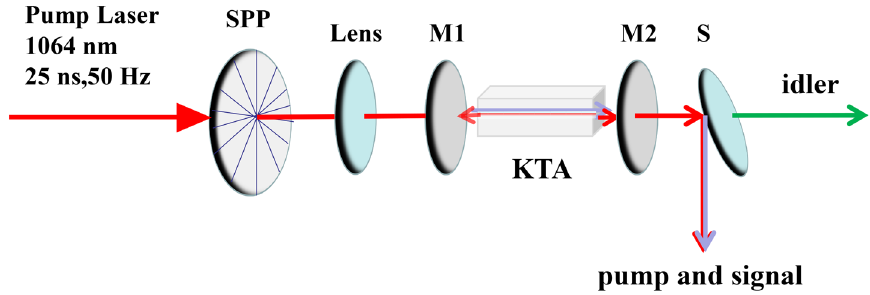
Figure 4. Experimental setup for near and mid infrared KTA optical vortex parametric